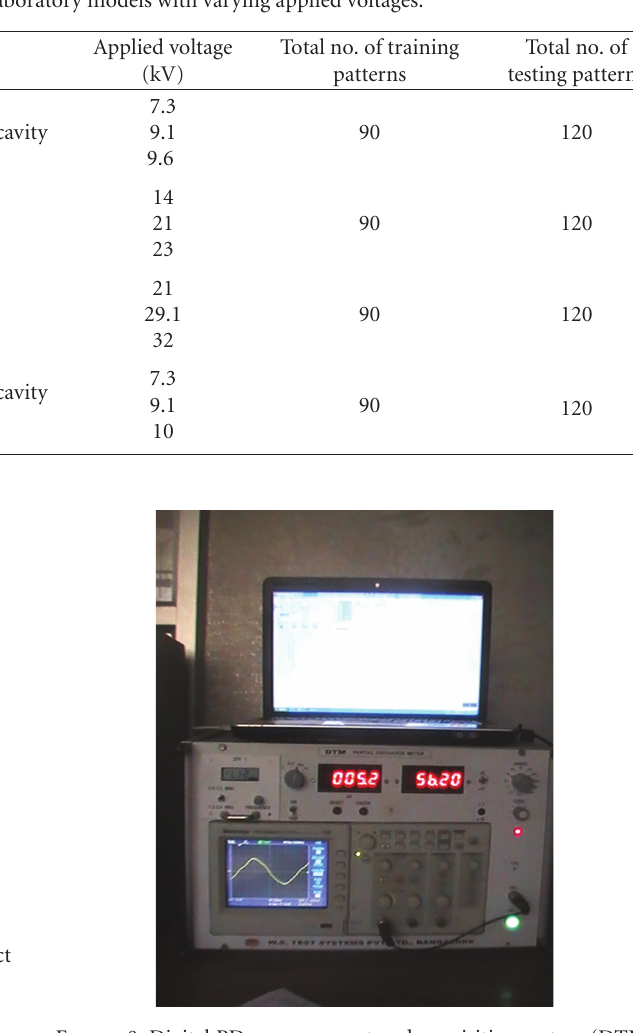
Figure 8: Digital PD measurement and acquisition system (DTM- D